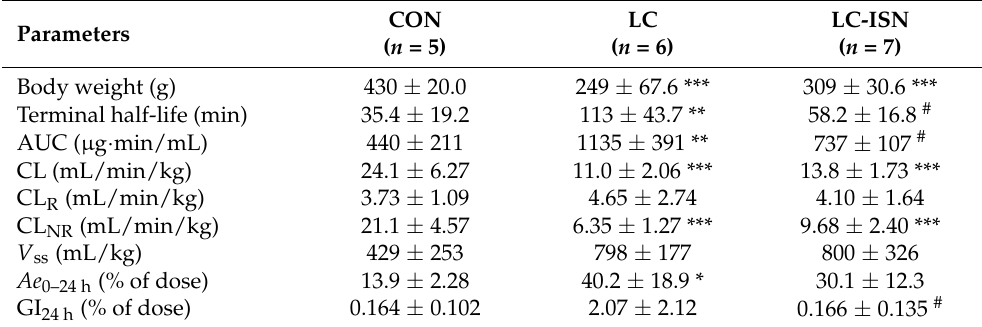
Table 2. Pharmacokinetic parameters of tofacitinib after 1 min intravenous infusion at a dose of 10 mg/kg toracitinib to CON, LC and LC-ISN rats. Data are shown as mean ± standard deviation.